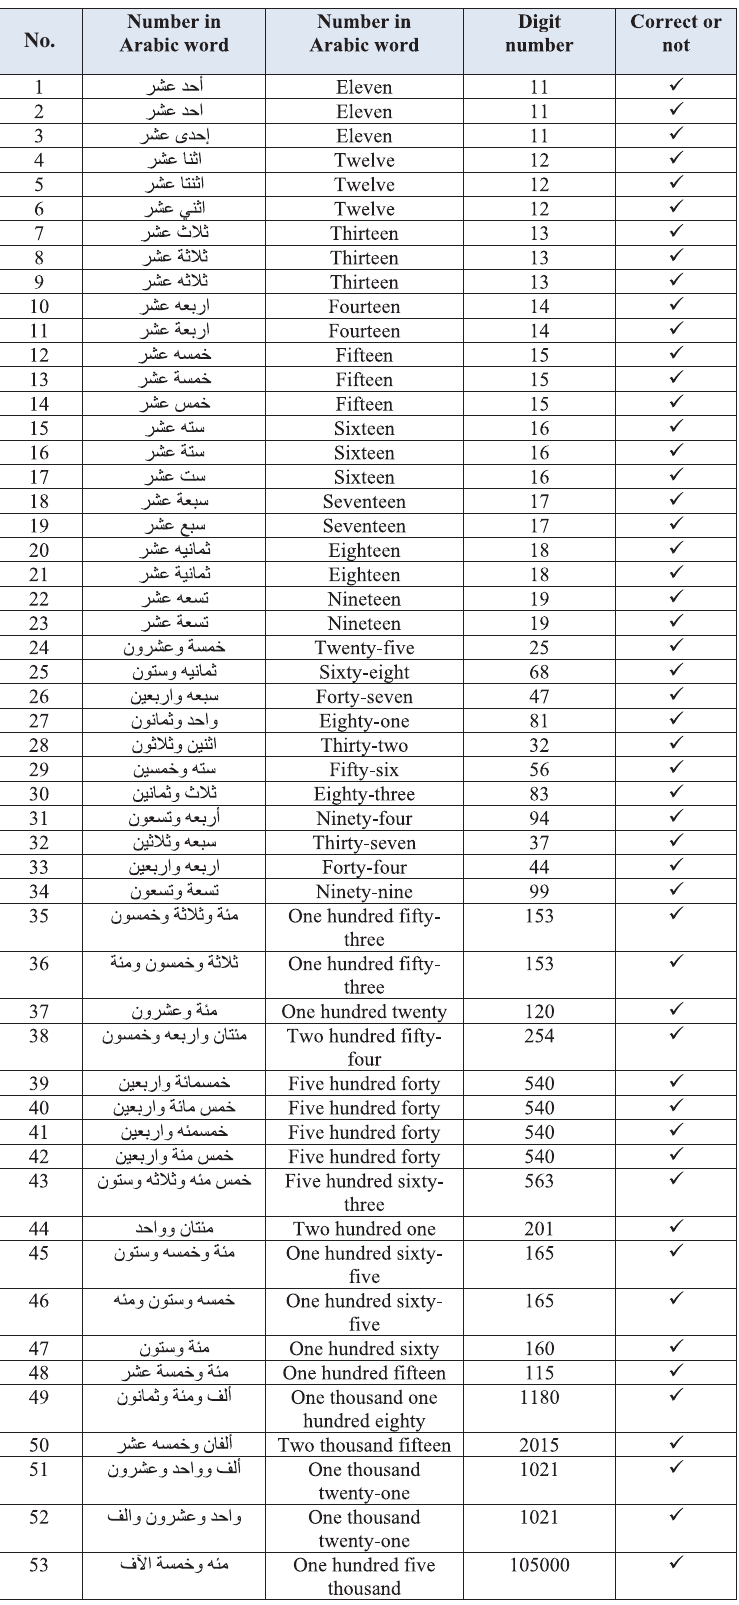
Table 3: The Results for Level of